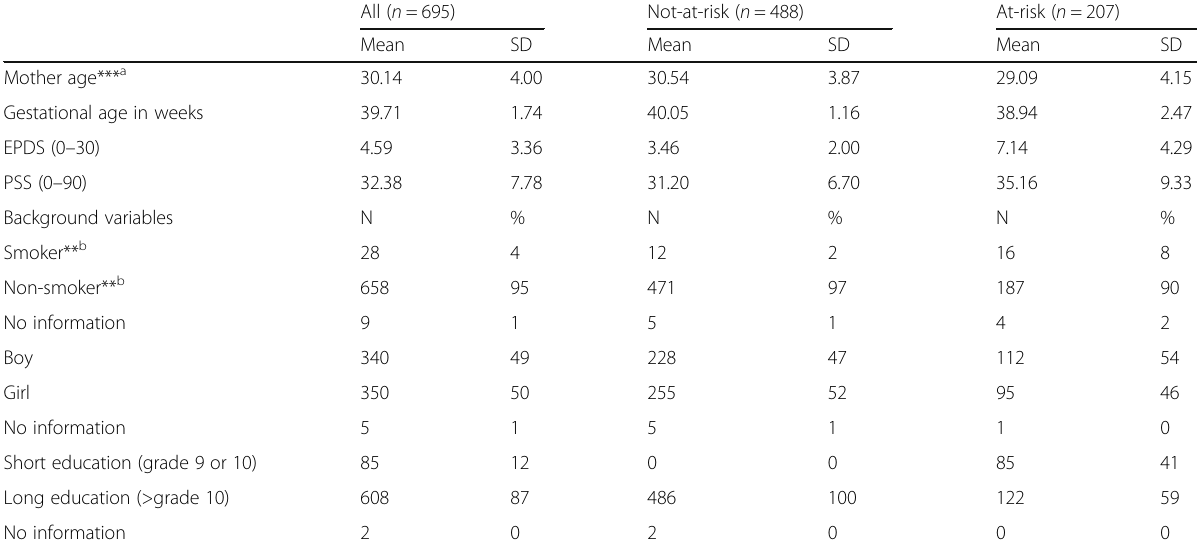
Table 1 Demographic characteristics of not-at-risk and at-risk mothers 2 months after birth All ( n = 695)